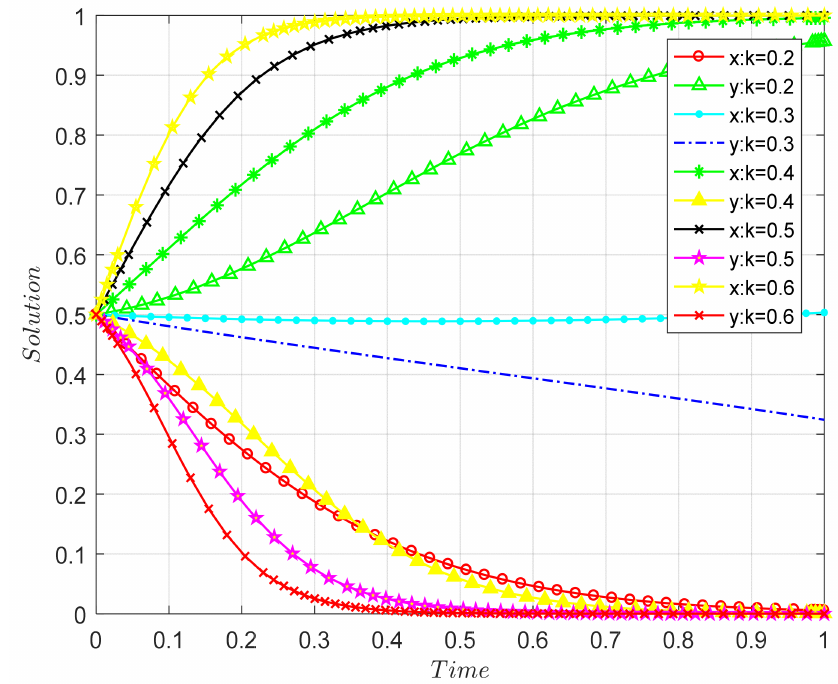
Figure 8. The effect of the profit increase coefficient k of the recycling unit on the evolution result of the two sides of the